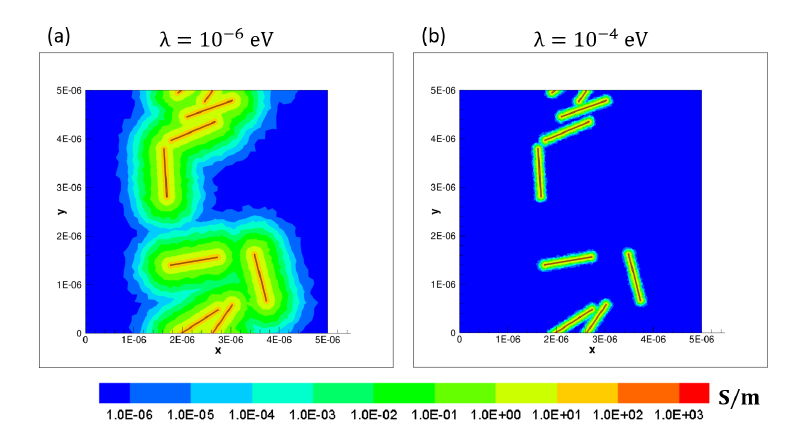
Figure 2. Contour plots of local conductivity for a specific 5 µ m × 5 µ m realization with randomly oriented CNTs at a volume fraction of 0.56% using ( a ) barrier potential λ = 10 − 6 eV (percolated case) and ( b ) barrier potential λ = 10 − 4 eV (unpercolated